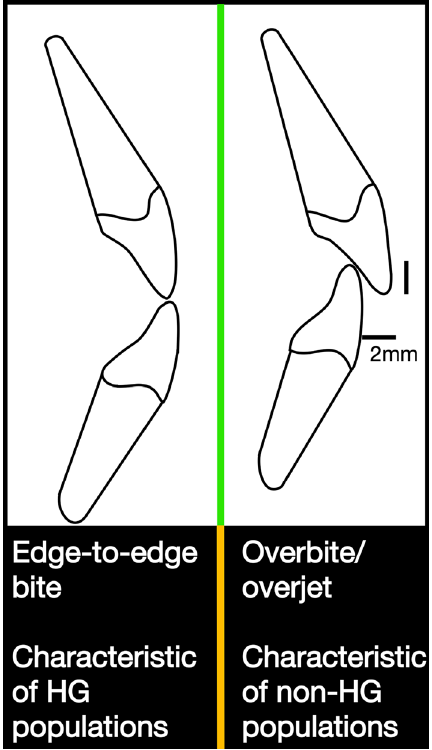
Figure 1. Incisor alignment associated with edge-to-edge bite and overbite/overjet, respectively. Adapted from Brunelle et al. 14 . The vertical black line represents the amount of overbite, the horizontal line represents the amount of overjet. 2 mm represents a common amount of